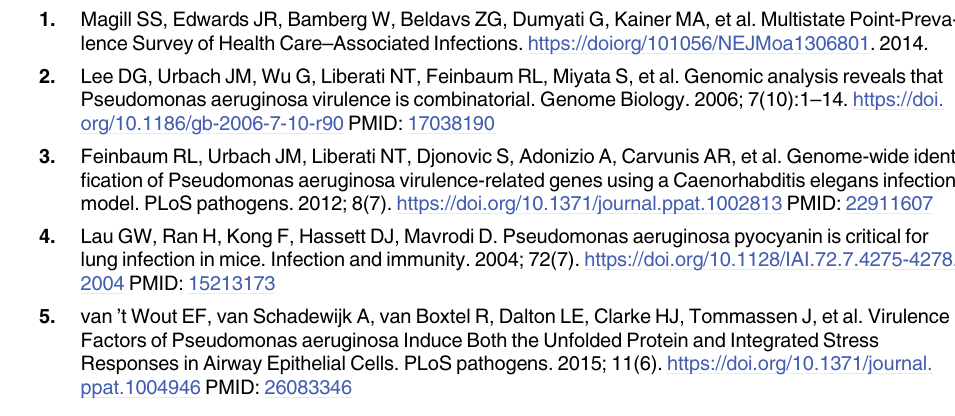
S2 Table. Genes of interest, their PAO1 reference name, and their associated biological activity